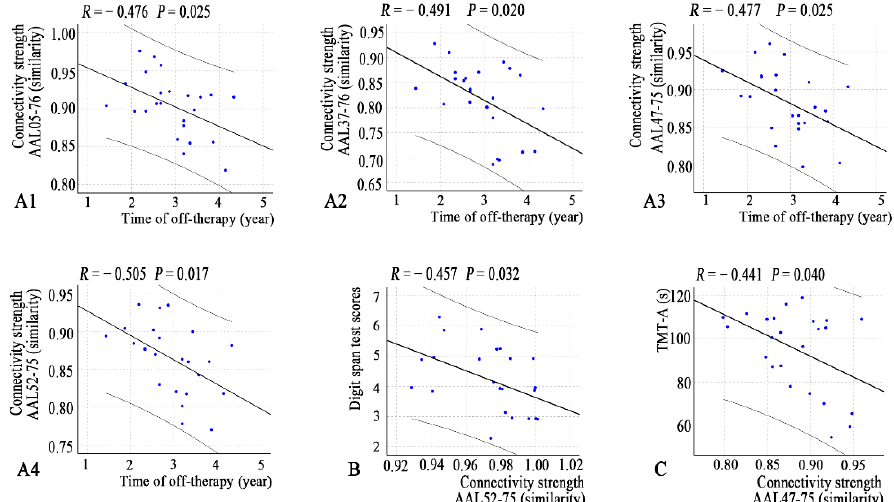
Figure 5. Correlations between connectivity strength and clinical variables (A1-A4, time of off-ther- apy; B, digit span test; C, TMT-A) in the young survivors of ALL. Note: AAL, anatomical automatic therapy; B , digit span test; C , TMT-A) in the young survivors of ALL. Note: AAL, anatomical labeling atlas; ALL, acute lymphoblastic leukemia. automatic labeling atlas; ALL, acute lymphoblastic